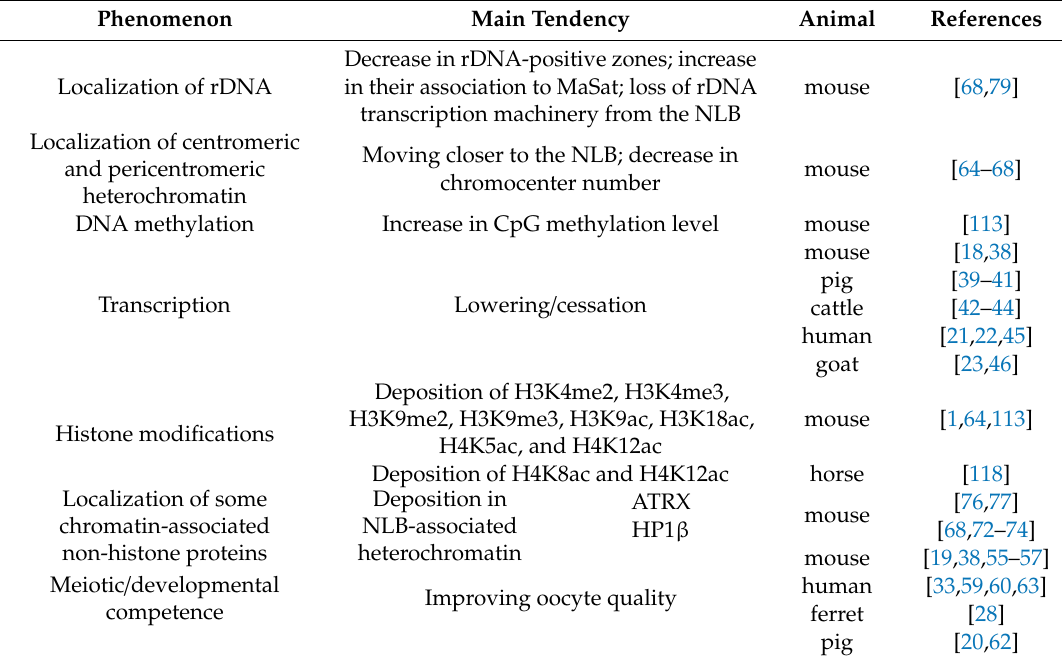
Table 2. Key phenomena of the NSN–SN